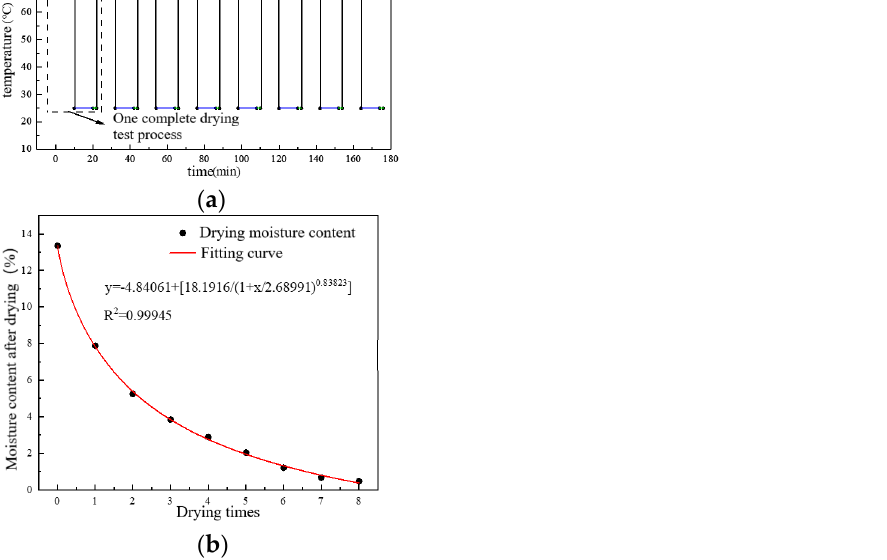
Figure 2. ( a ) Drying test path; ( b ) moisture content of successive drying results.